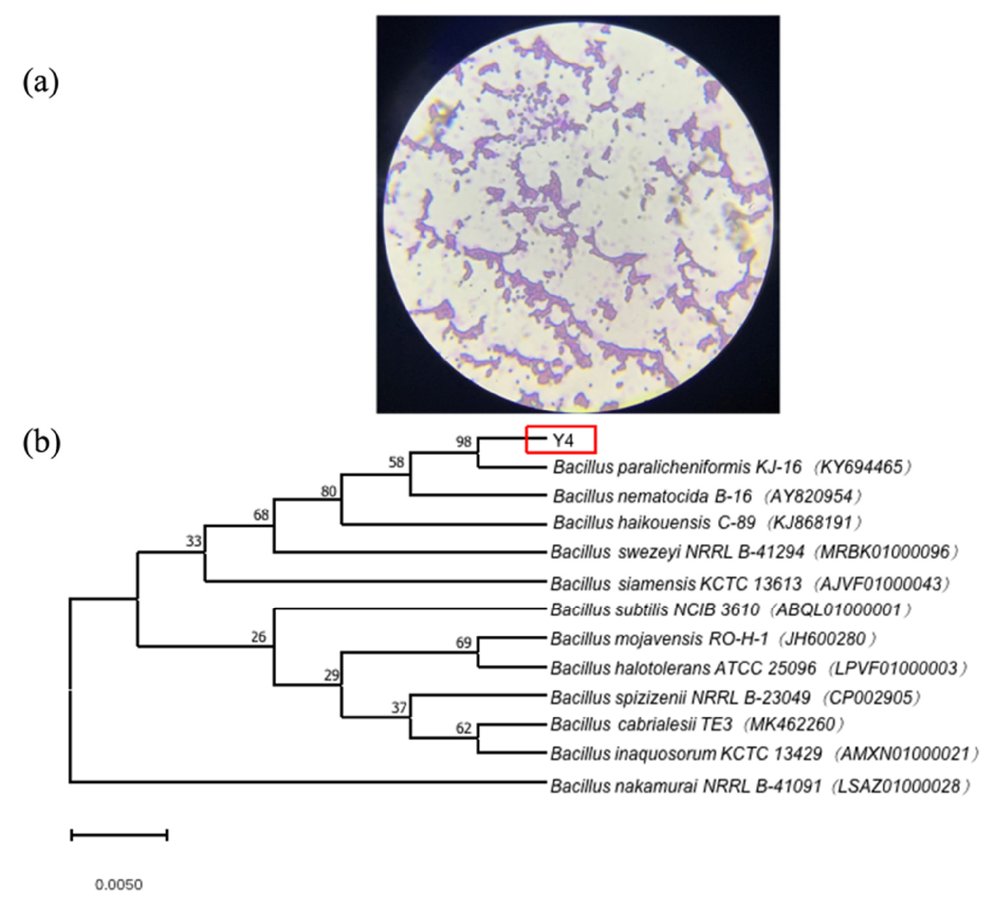
Figure 3. Characterization of strain Y4. Gram staining of strain Y4 ( a ) Neighbour-joining tree inferred through MEGA software based on the sequences of 16S rRNA gene, showing the phylogenetic relationship of strain Y4 and related species obtained from the Ezbiocloud website ( b ).